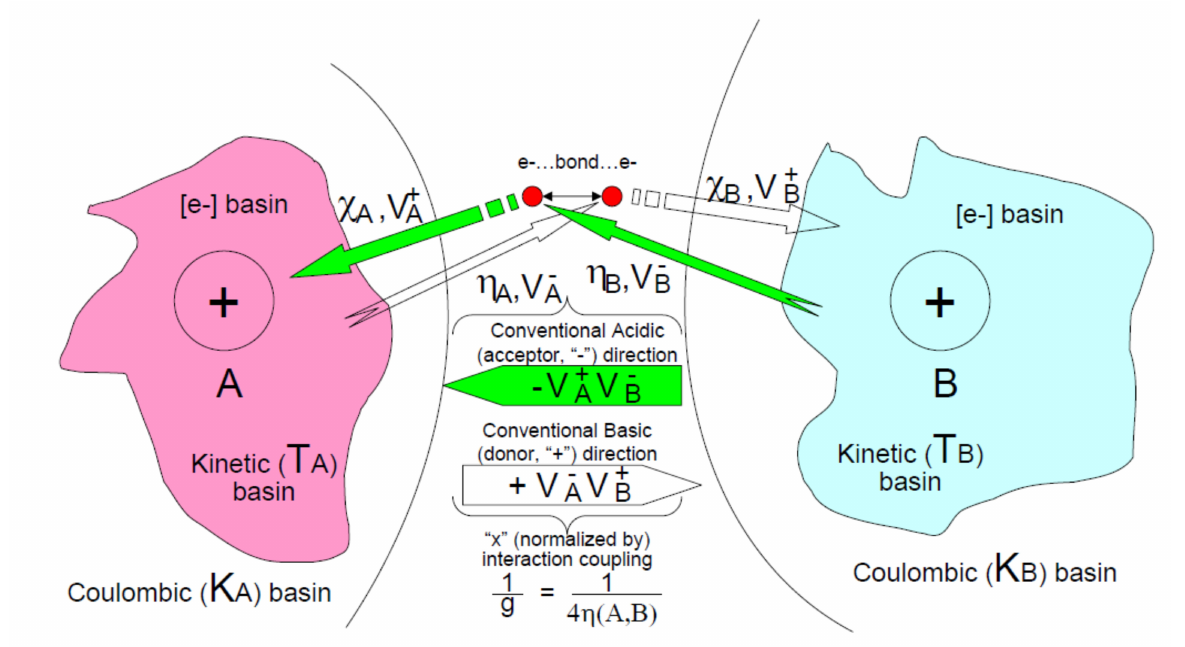
Figure A1. Adds-in-bonding modeling by normalized chemical reactivity scattering picture; see text for further